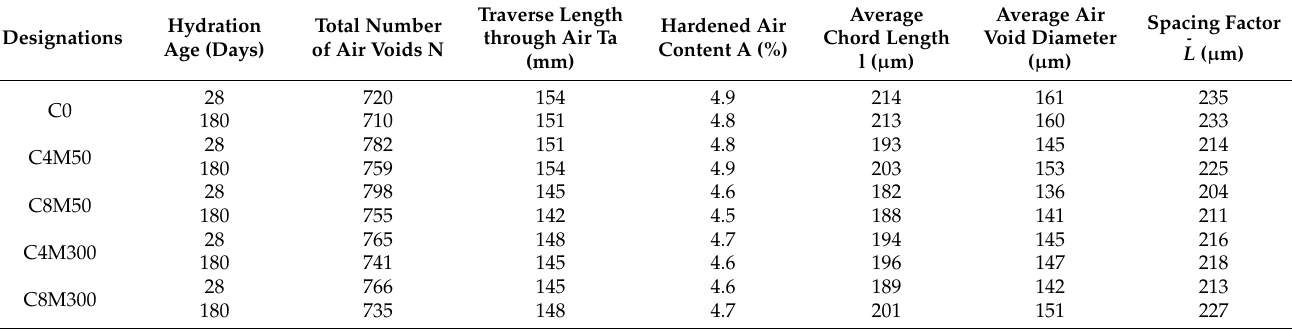
Table 5. Air void parameters of 28-day and 180-day concretes containing MgO with different reactivities and